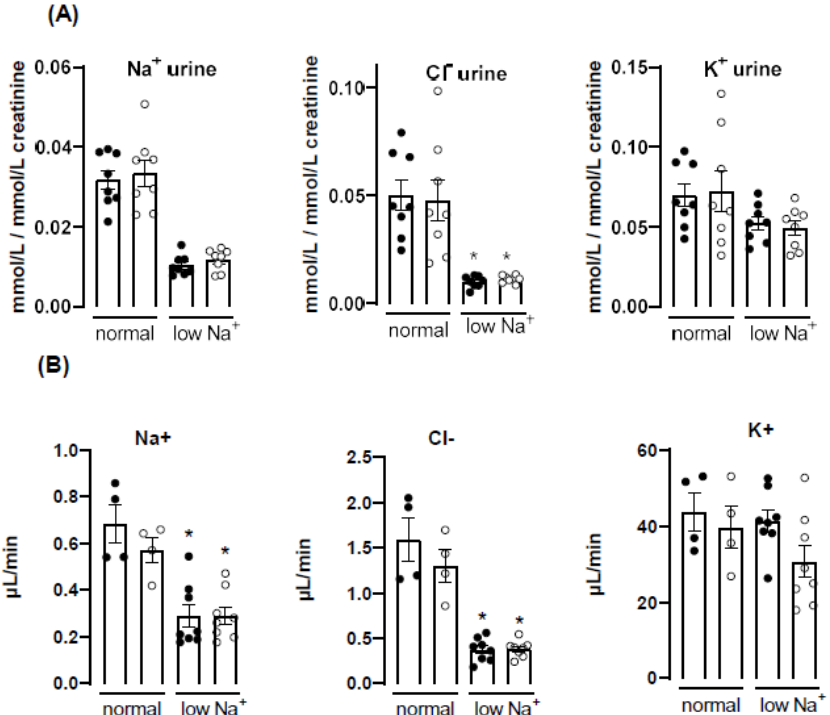
Figure 4. Electrolyte excretion and clearance under normal and low Na+ diet. ( A ): excretion of Na + , Cl − and K + , normalized by urine creatinine. ( B ): clearance of Na + , Cl − and K + . * p < 0.05, non-parametric test, Mann–Whitney, normal vs. low Na+ diet. Data are mean ± SEM. n ≥ 4.